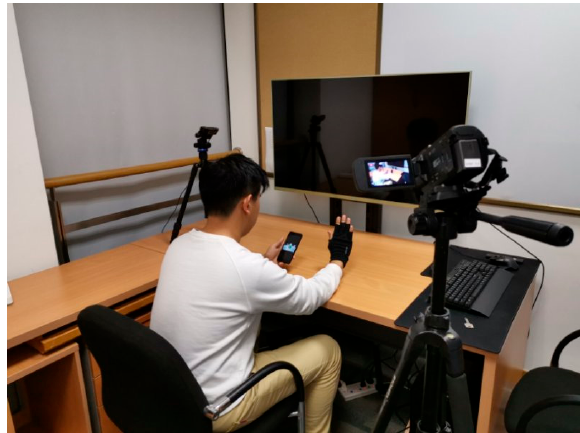
Figure 2. A participant is performing a gesture while wearing the fabric-based prototype on the right hand and holding the handheld augmented reality (HAR) device on the left hand. Two cameras were used the capture the entire process. Table 1. The selected list of 27 HAR tasks used in our study. The tasks are classified into three different categories and presented via our HAR app.